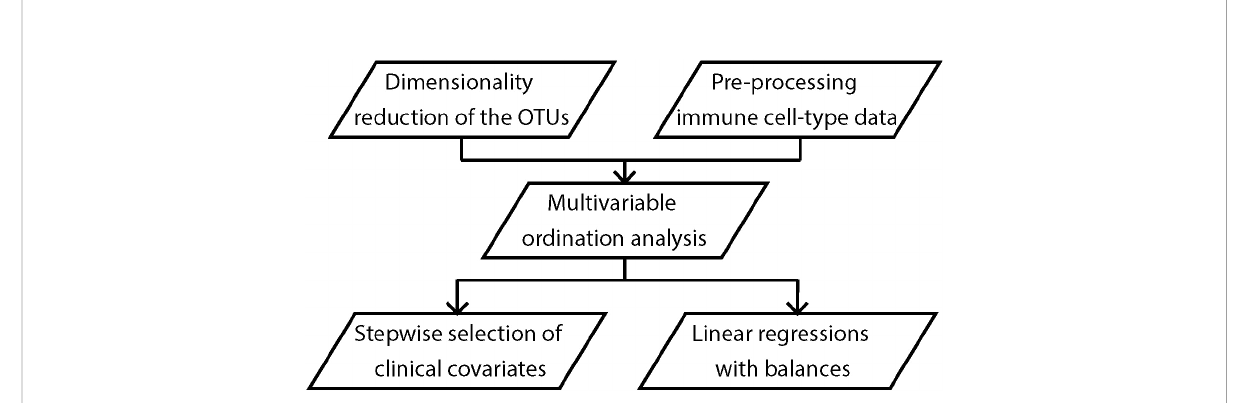
FIGURE 2 Analysis work fl ow. All analyses were performed on maternal OTU clusters and/or infant immune pro fi le at birth, 6 and 12 months of